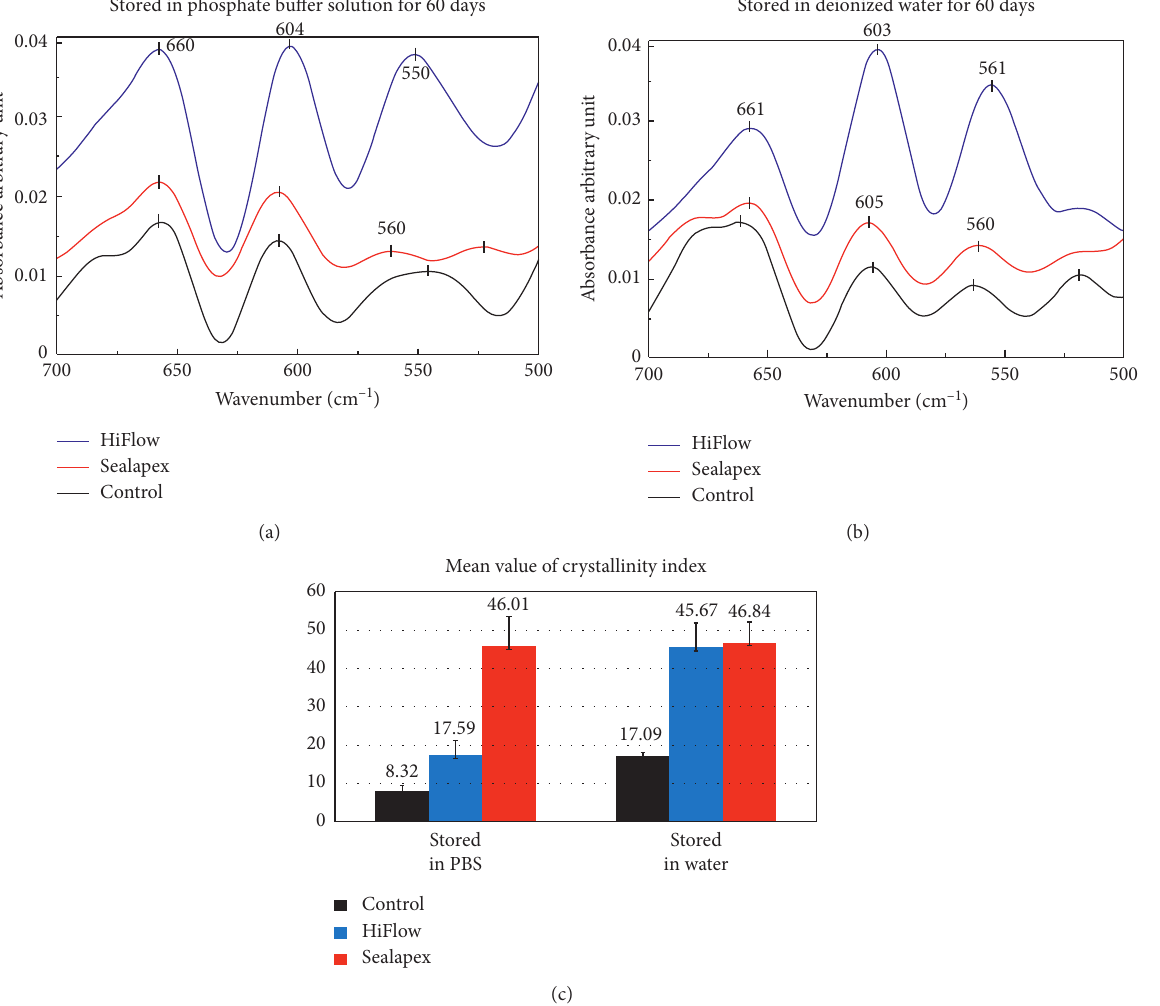
Figure 2: FTIR spectra of dentin stored in phosphate buffer solution (a) and deionized water (b) for 60 days. Both sealers induced increases in the mean value of crystallinity index (CI FTIR ) as compared with control untreated dentin